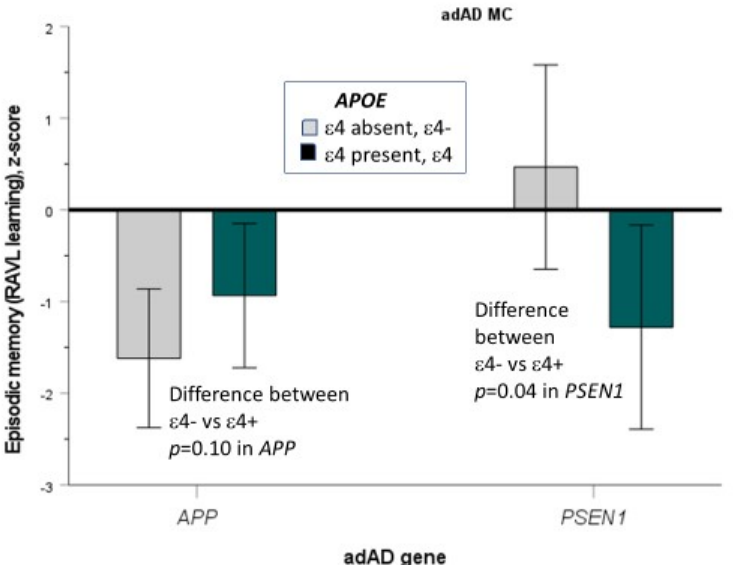
Figure 2. A graph showing mean (95% CI) episodic memory performance (RAVL learning) between APOE ε 4positive and ε 4 negative mutation carriers of APP and PSEN1 adAD genes.